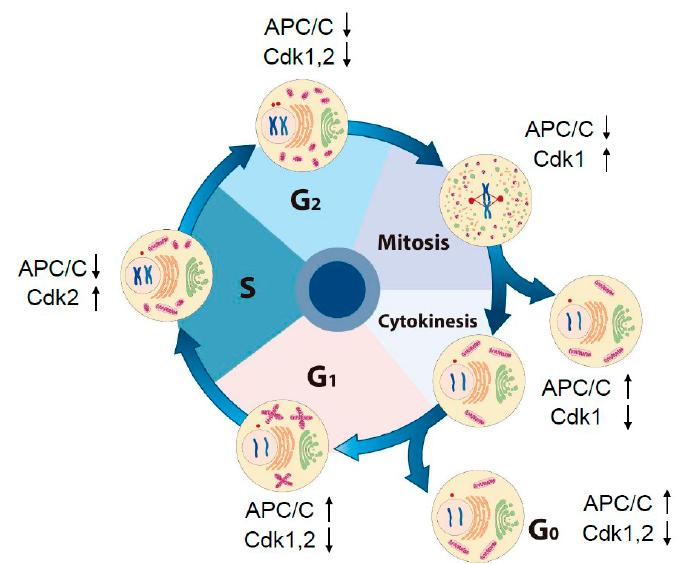
Figure 1. The morphological change in subcellular compartments and the activities of cell cycle-dependent kinases (Cdks) and anaphase-promoting complex / cyclosome (APC / C) throughout the cell cycle in a mammalian cell: During the cell cycle, after DNA replication is finished at the S phase, a cell prepares to enter mitosis through the G 2 phase. At the G 2 –M transition, the structure of subcellular organelles is changed dramatically as illustrated here. A nuclear envelop is broken and the Golgi (green), ER (yellow), and mitochondria (pink) are fragmented. After mitotic exit, all the organelles are reorganized and structured in filamentous states. Activity of APC / C is inversely propositioned to that of Cdks during cell cycle progression except at the G 2 phase. APC / C activity is inhibited by early mitotic inhibitor1 at the G 2 phase. In G 0 (quiescent phase) cells, APC / C–Cdh1 remains active.